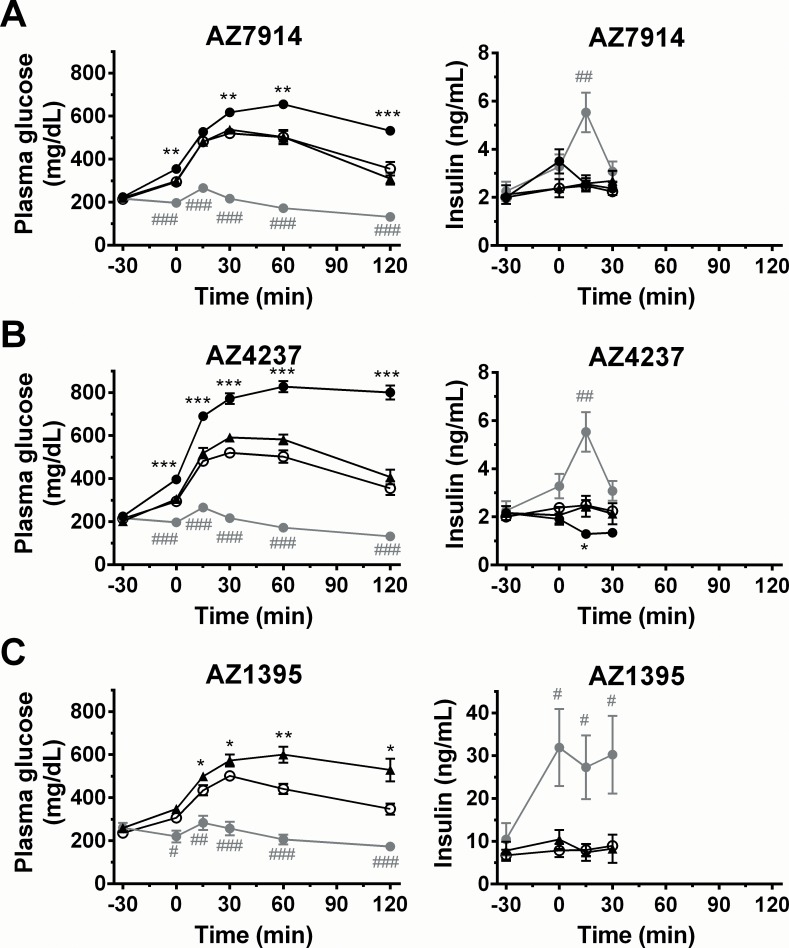
IPGTT in DIO mice; AZ7914 (A), AZ4237 (B), AZ1395 (C).Compounds (black triangles: 30 mg/kg, black circles: 100 mg/kg, grey circles: exendin-4, 1 μg/kg) or vehicle (white circles) were IP administered to fasted DIO mice at -30 min. Glucose solution (1.0 g/kg) was IP given at 0 min. Values are mean ± SEM (n = 7). #
P<0.05, ##
P<0.01, ###
P<0.001 versus vehicle (repeated measures ANOVA followed by student’s t-test).*P<0.05, **P<0.01, ***P<0.001 versus vehicle (repeated measures ANOVA followed by Dunnett).